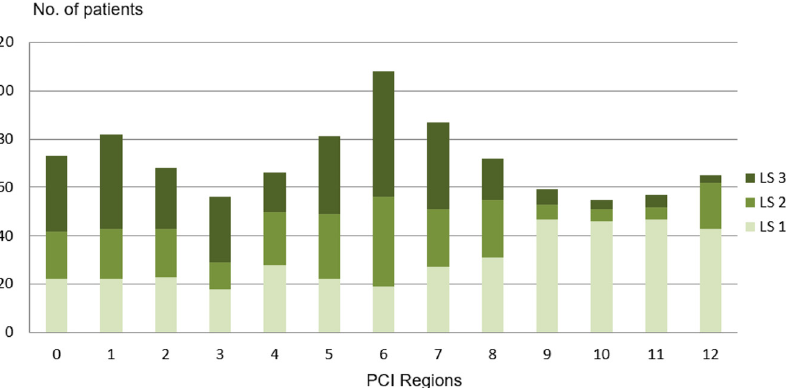
Figure 1: Pattern of PCI